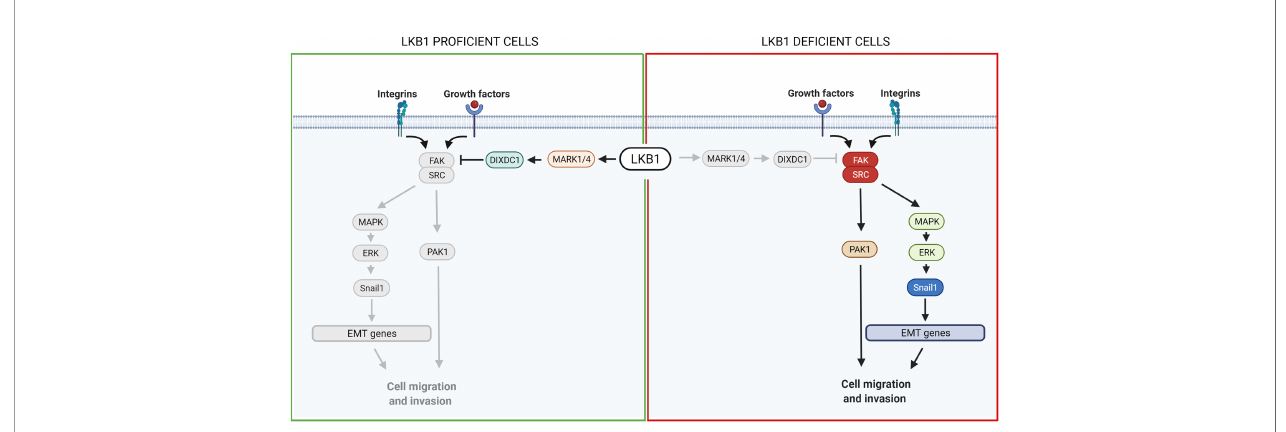
FIGURE 3 | Scheme of LKB1 downstream pathways involved in metastasis and possible target for pharmacological prevention of metastases. On the left, it is shown the pathway in LKB1-pro fi cient cells, while on the right in LKB1-de fi cient cells. Grey lines and grey circles indicate the inactivation of that way. The red circle proteins on the right show the possible targets for a pharmacological inhibition of LKB1 -mutated NSCLC metastasis. Created with